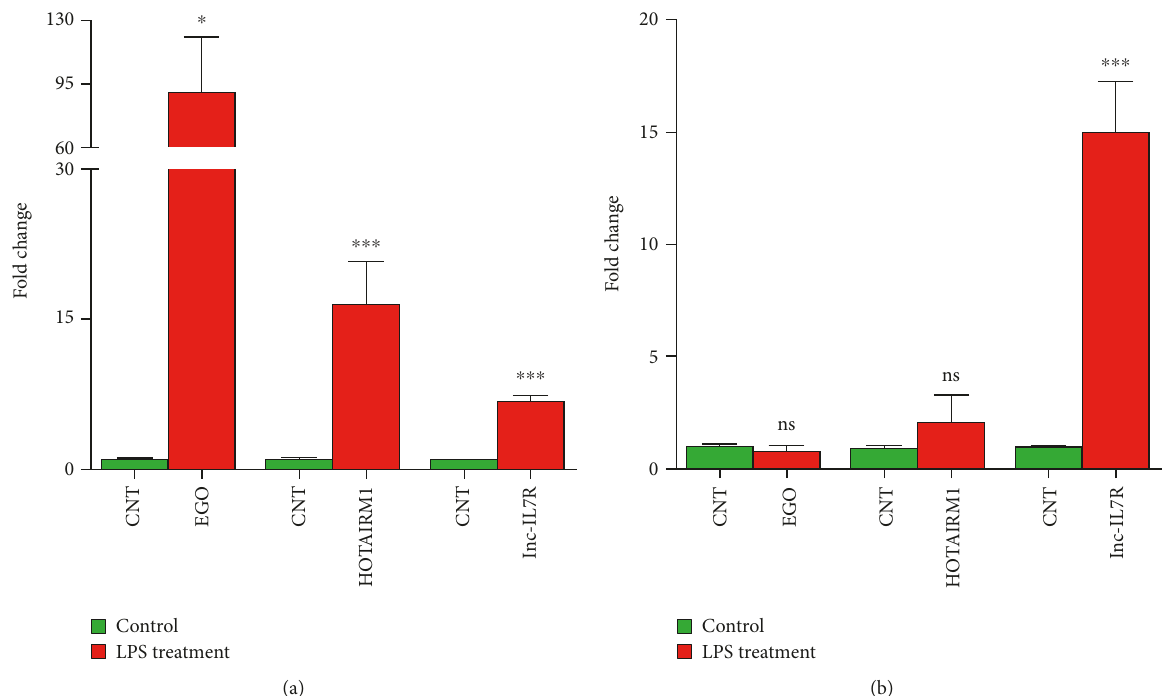
Figure 7: Quantitative RT-PCR for EGO (NONHSAT087634), HOTAIRM1 (NONHSAT119666), and lnc-IL7R expression in HMECs following LPS treatment for (a) 3 h and (b) 24h ( ∗ P ≤ 0 05 and ∗∗∗ P ≤ 0 001 ; and ns=nonsigni fi